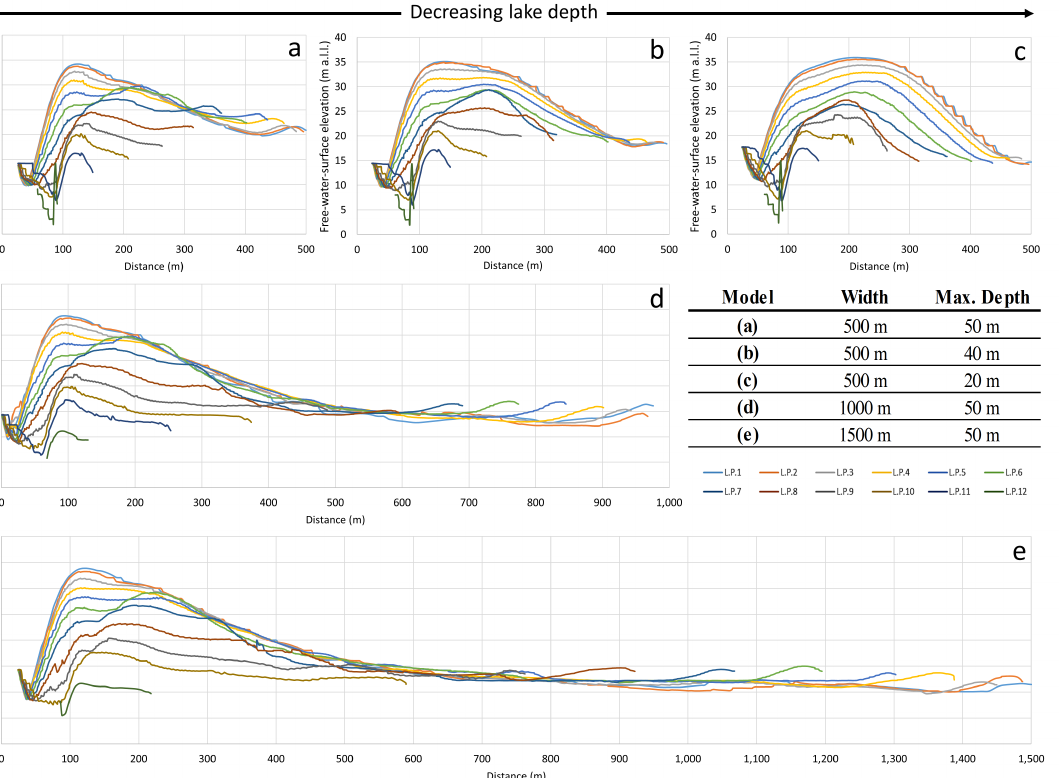
Figure 5. Free-water-surface elevation computed along with the L.Ps (e.g., Figure 4d) for typical circular artificial lakes with different widths and maximum depths ( a – e ). Each lake configuration influences the landslide–water interaction and wave dissipation, thus causing different impulse wave propagation